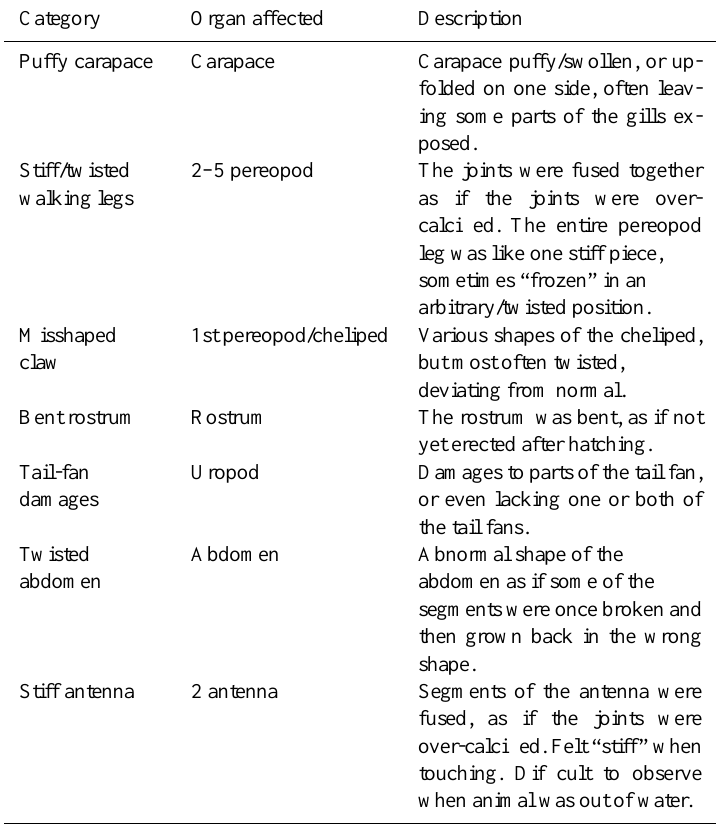
Table 3. Classification of deformities found in juvenile stages of European lobster ( Homarus gammarus) exposed to elevated p CO 2 levels. Category Organ affected Description Puffy carapace Carapace Carapace puffy/swollen, or up- folded on one side, often leav- ing some parts of the gills ex- posed. Stiff/twisted 2–5 pereopod The joints were fused together walking legs as if the joints were over- calcified. The entire pereopod leg was like one stiff piece, sometimes “frozen” in an arbitrary/twisted position. Misshaped 1st pereopod/cheliped Various shapes of the cheliped, claw but most often twisted, deviating from normal. Bent rostrum Rostrum The rostrum was bent, as if not yet erected after hatching. Tail-fan Uropod Damages to parts of the tail fan, damages or even lacking one or both of the tail fans. Twisted Abdomen Abnormal shape of the abdomen abdomen as if some of the segments were once broken and then grown back in the wrong shape. Stiff antenna 2 antenna Segments of the antenna were fused, as if the joints were over-calcified. Felt “stiff” when touching. Difficult to observe when animal was out of